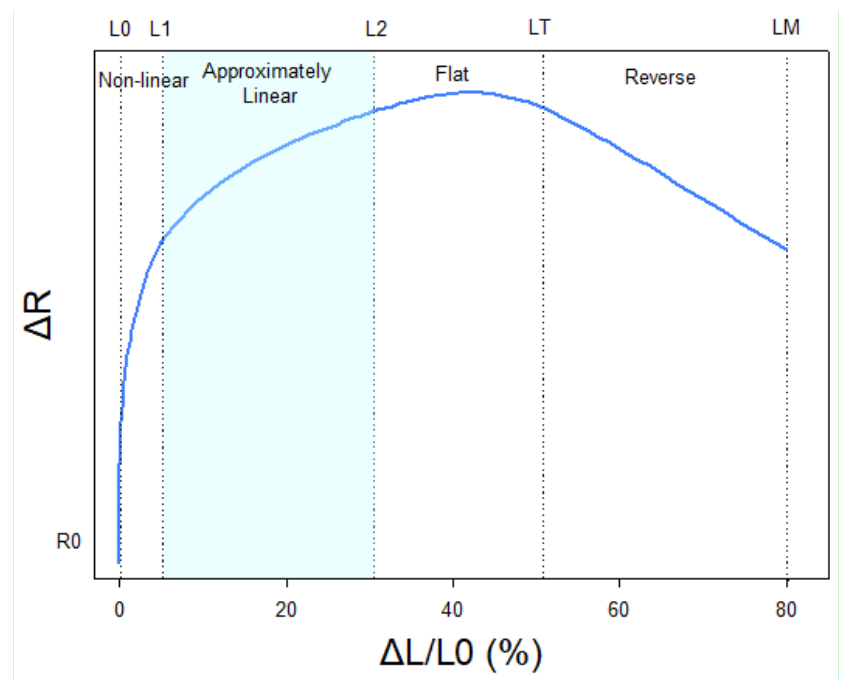
Figure 2. Stretch metallic knit “static” resistance qualitative curve. The graph shows the non-linear resistance/stretch curve of the resistive fabric and the different ranges of resistance (non-linear, approximately linear, flat and reverse, with LT the length threshold above which resistance decreases and LM indicating the maximum length). The section in evidence indicates the operative range.